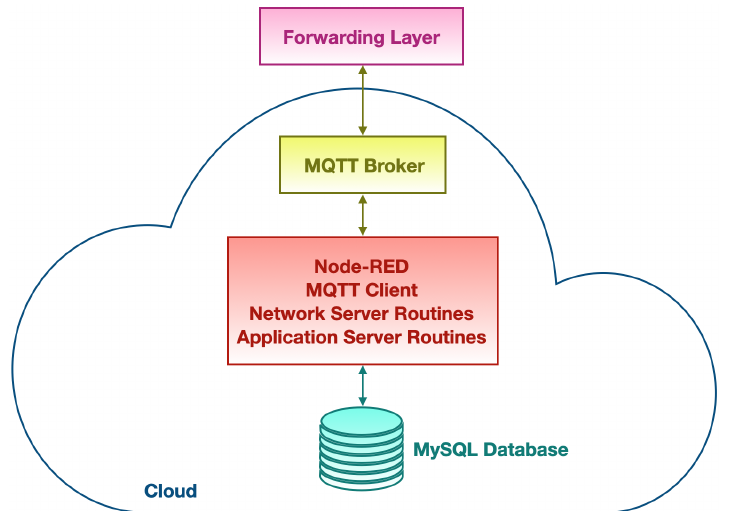
Figure 5. Cloud Layer block scheme architecture. The Forwarding Layer is included for the sake of completeness. Marsh grass arrows represent MQTT links, while the turquoise arrow stands for database